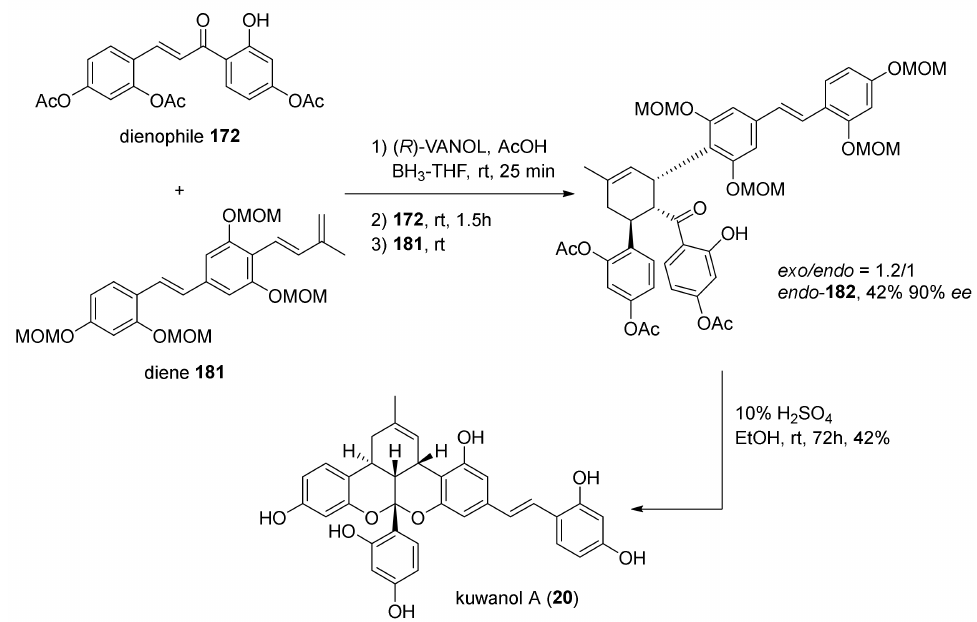
Figure 61. Synthesis of kuwanol A ( 20 ) from MOM-protected diene 173